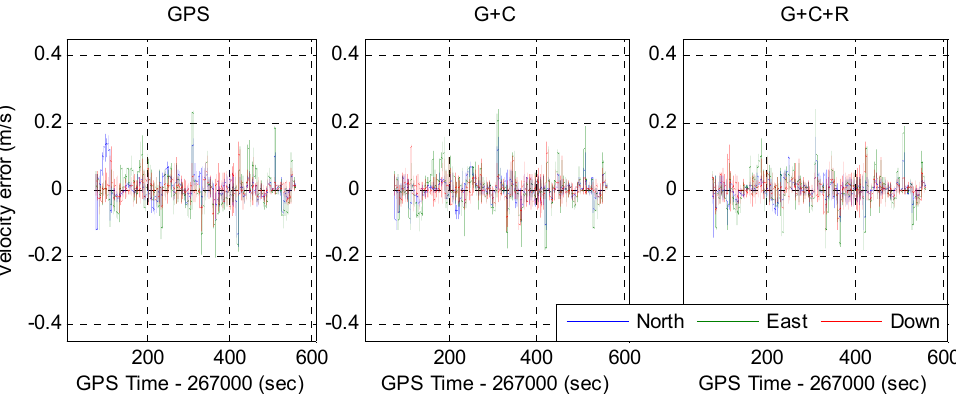
Figure 15. Velocity error of the tightly coupled RTK/INS integration for the GPS, GPS + BDS (G + C), and GPS + BDS + GLONASS (G + C + R) systems. Remote Sens. 2019 , 11 , x FOR PEER REVIEW